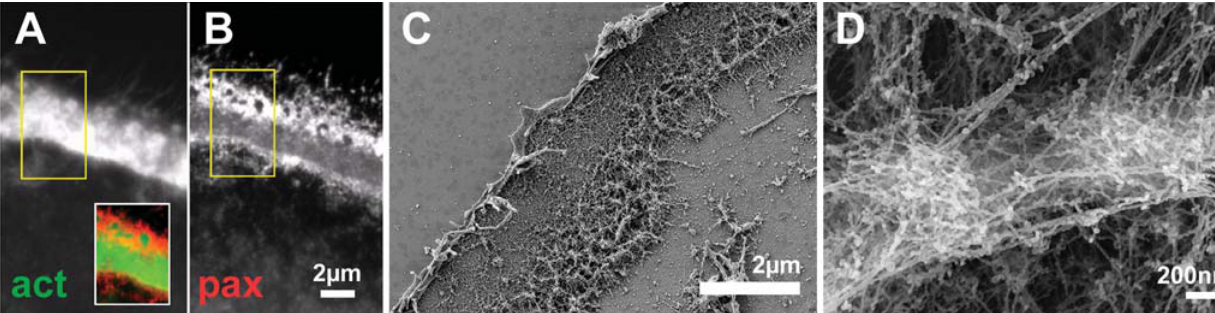
Figure 3. Sealing zone-like structure. Intact osteoclast (A,B) or ventral membrane (C, D) on glass cover-slips were fixed and stained for actin (A) or paxillin (B) or prepared for HR-SEM (C–D). (A) A dense actin belt is surrounded by inner and outer paxillin belts (B). The insert in (A) shows a merged image of actin/paxillin staining. (C) SEM over-view of a sealing zone-like structure on glass: note the continuous, robust actin organization. (D) Higher magnification view of two neighboring pillars showing numerous inter-pillar cables.